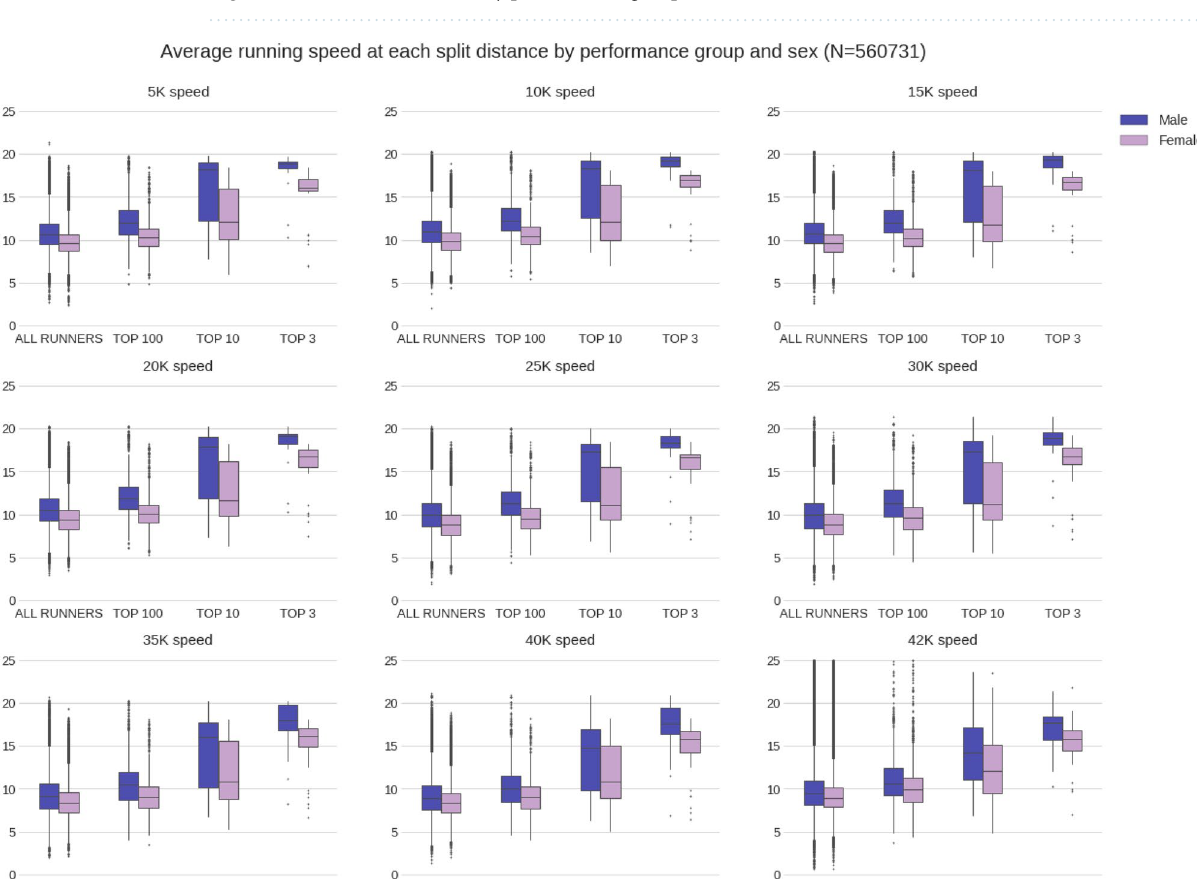
Figure 5. Average running speed at each split distance by performance group and